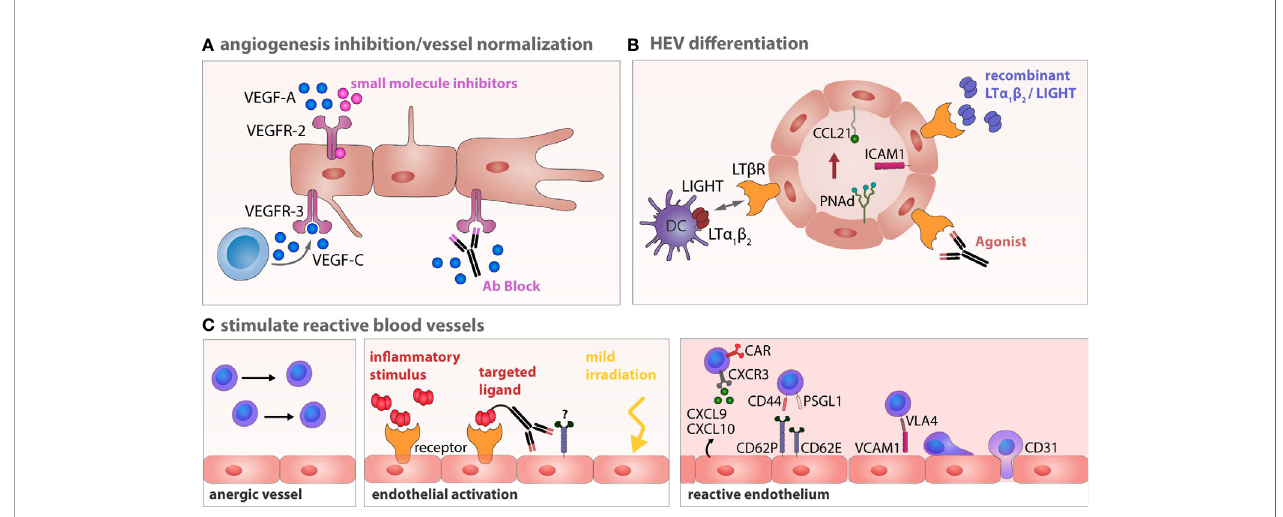
FIGURE 3 | Therapeutic strategies to induce vessel normalization and revert endothelial anergy in B-NHL. (A) Anti-angiogenesis therapy tageted at VEGFR-2 or VEGFR-3 can restore a normalized vessel network. (B) Targeting of the LT b R with LT a 1 b 2 and LIGHT expressing DCs, agonistic antibodies or recombinant factors potentially circumvents impaired lymphocyte homing by establishing or stabilizing HEV integrity within the lymphoma TME (338). (C) Vessel anergy can be changed by a targeted conversion of the endothelium toward a reactive endothelium using in fl ammatory cytokines, which might be site directed to avoid unintended systemic effects. Normalization of aberrant vessels and activation of the endothelium can also be achieved by locally applied low-dose gamma irradiation (339). Reactive endothelium within LNs is a prerequisite for an effective in fi ltration of effector T cells during cellular